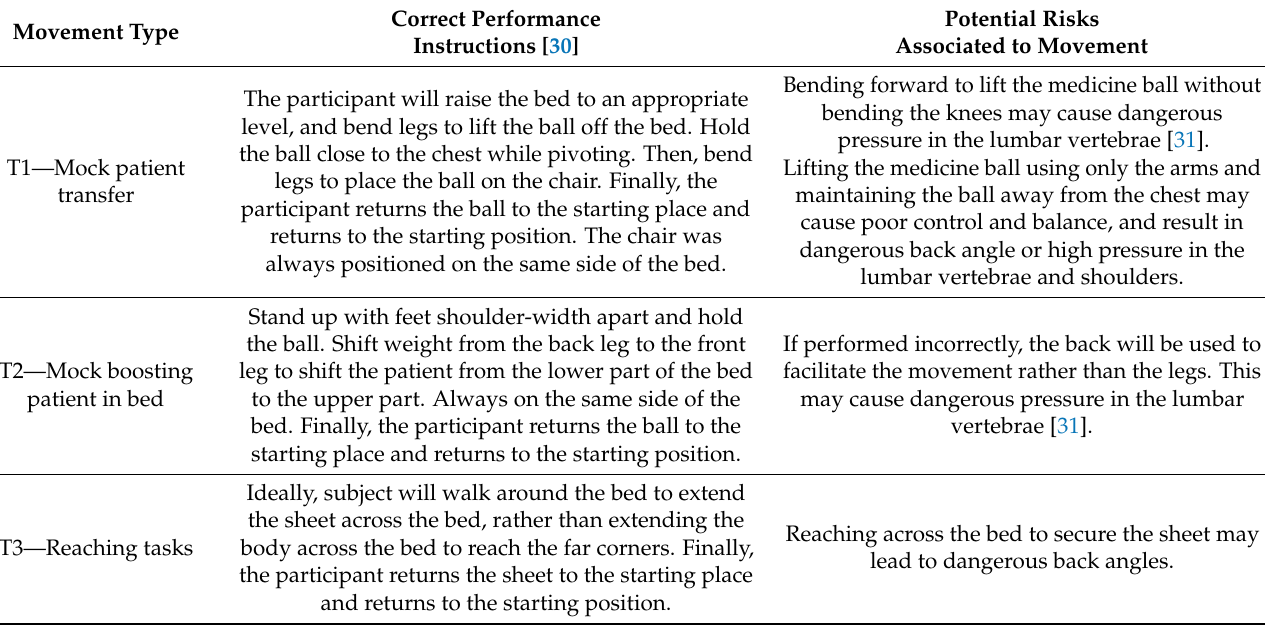
Table 1. Performance for each